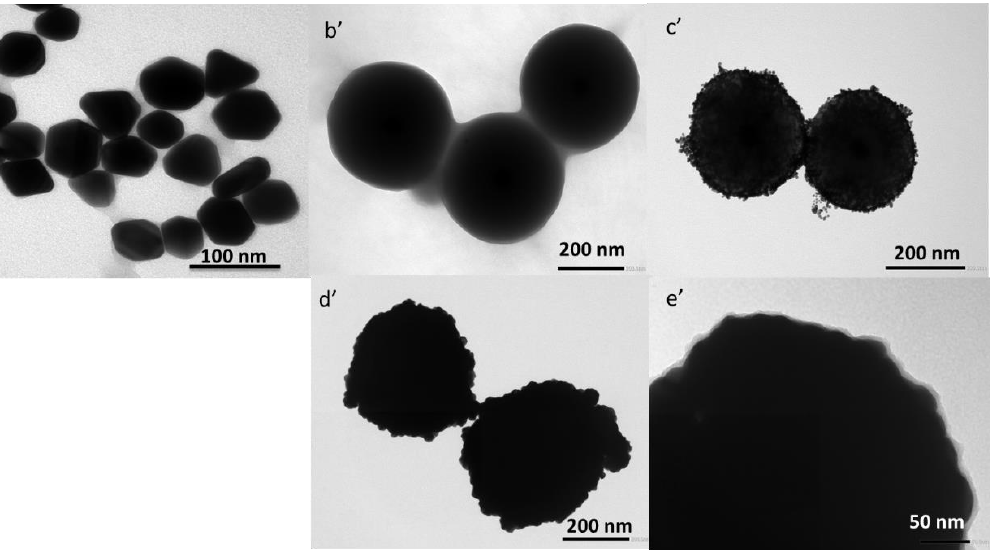
Figure 4. TEM images: AuNP@CTAB (50 – 70 nm) ( a’ ); AuNP@SiO 2 (250 nm) ( b’ ); AuNP@SiO 2 @seed ( c’ ); AuNP@SiO 2 @Au (350 nm) ( d’ ); AuNP@SiO 2 @Au@SiO 2 ( e’ ).